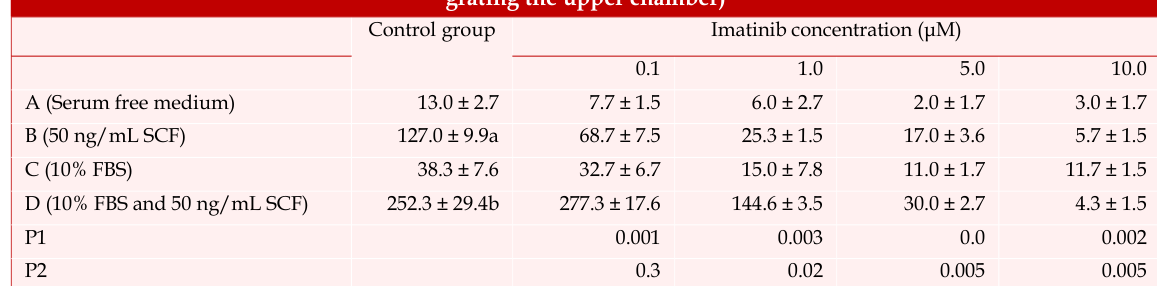
Effect of 50 ng/mL SCF and imatinib at different concentrations on NHEM migration (number of cells mi- grating the upper